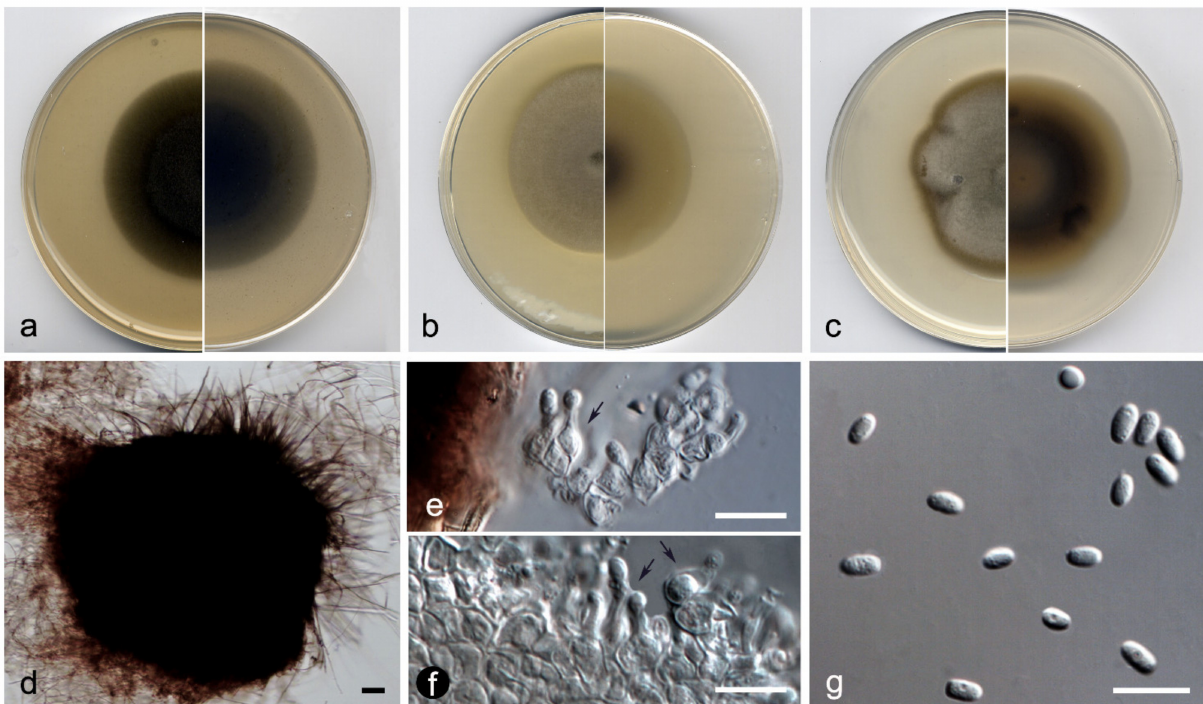
Figure 6. Paraphoma aquatica FMR 16956: ( a ) colonies on OA; ( b ) MEA; and ( c ) PDA after two weeks at 25 ± 1 ◦ C (surface, left; reverse, right); ( d ) pycnidium; ( e , f ) conidiogenous cells (black arrows); ( g ) conidia. Scale bars: ( d ) = 25 µ m, ( e – g ) = 10 µ